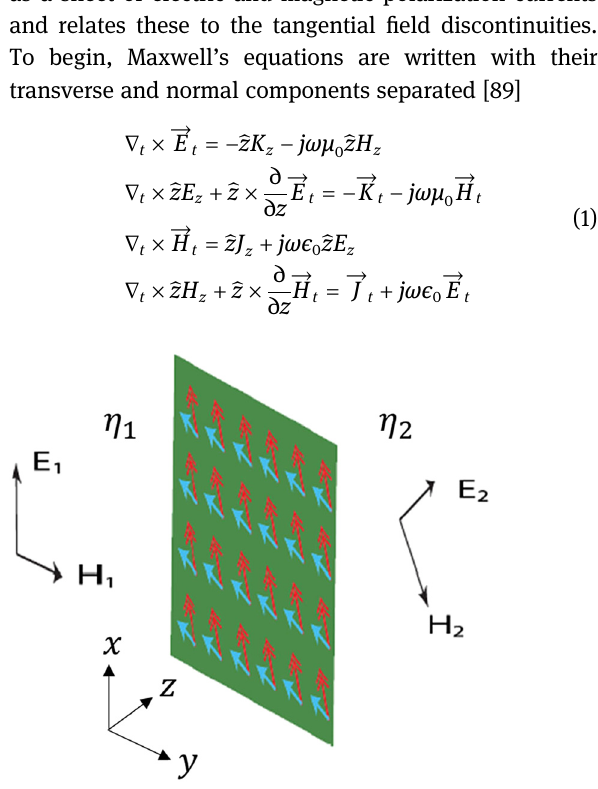
Figure 1: Metasurface geometry. The metasurface consists of a periodic arrangement of polarizable magnetoelectric particles separated by a sub-wavelength